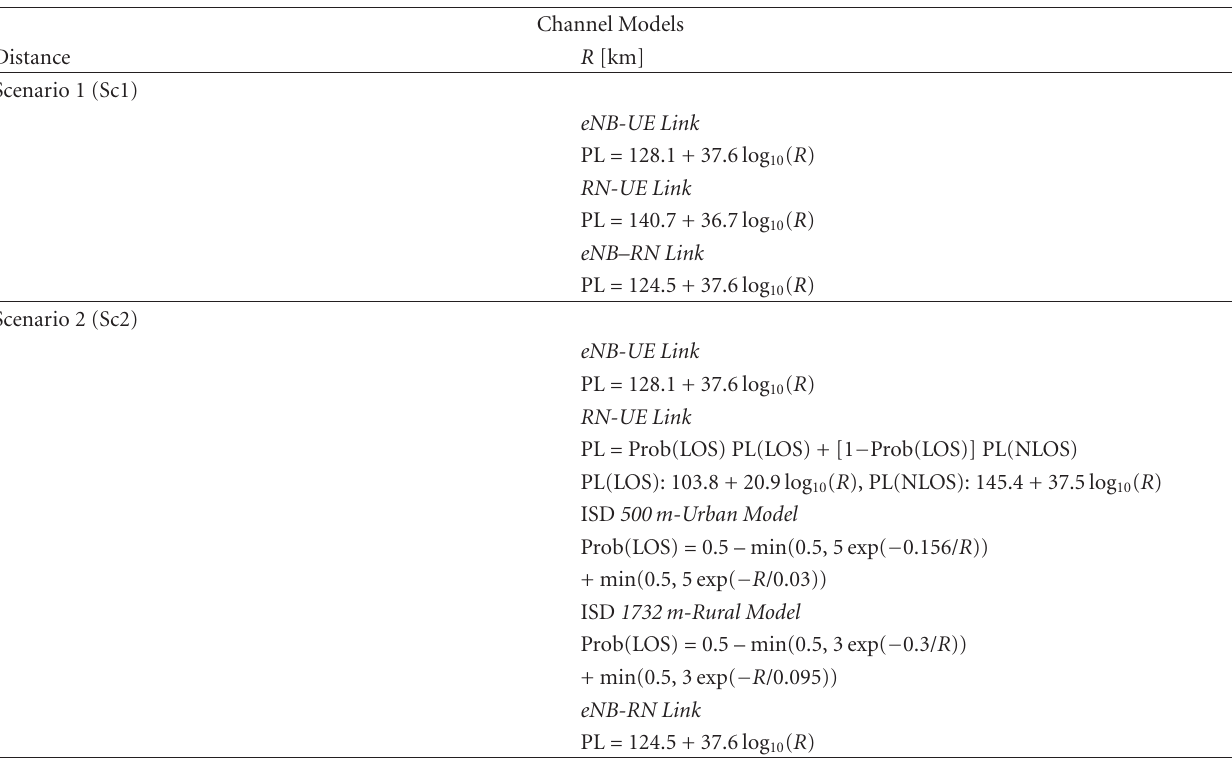
Table 1: Propagation